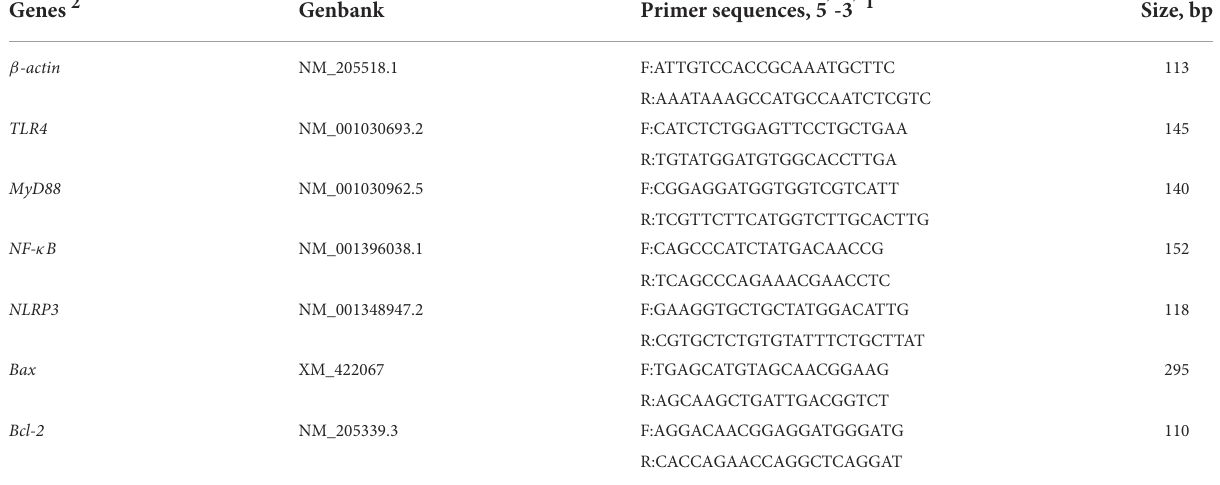
TABLE 2 Primer sequences used for fluorescent quantitation PCR.